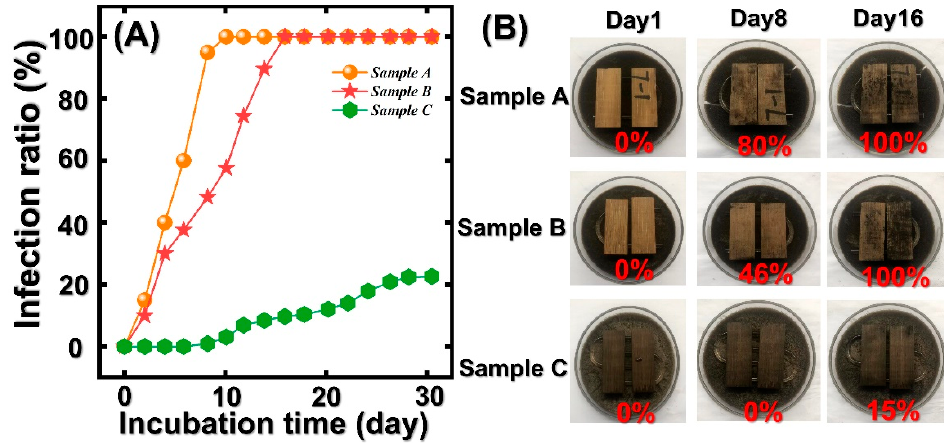
Figure 7. The anti-mildew property of the control and treated bamboo samples in 30 days: ( A ) Infection ratio of untreated bamboo and treated bamboo in 30 days and ( B ) corresponded figures of anti-mildew test. Table 1. Summary of the anti-mildew property of treated bamboo in different references.